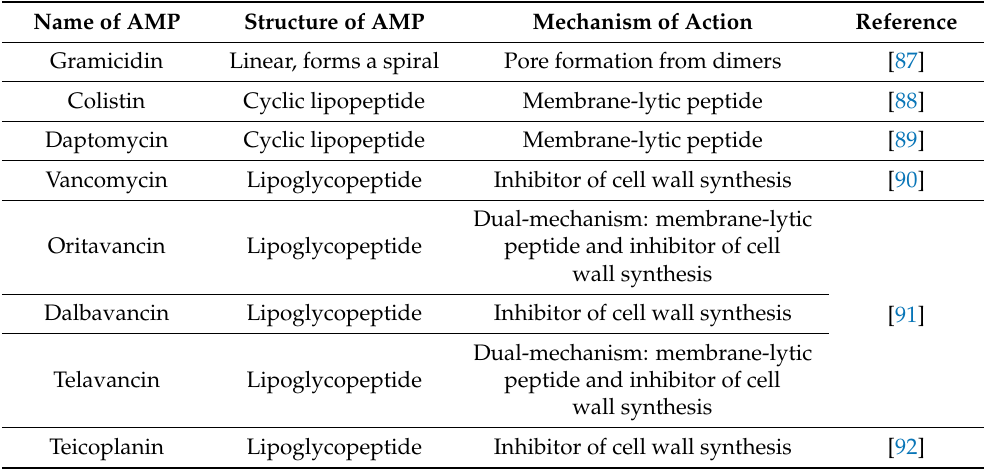
Table 1. List of AMPs approved by the FDA as